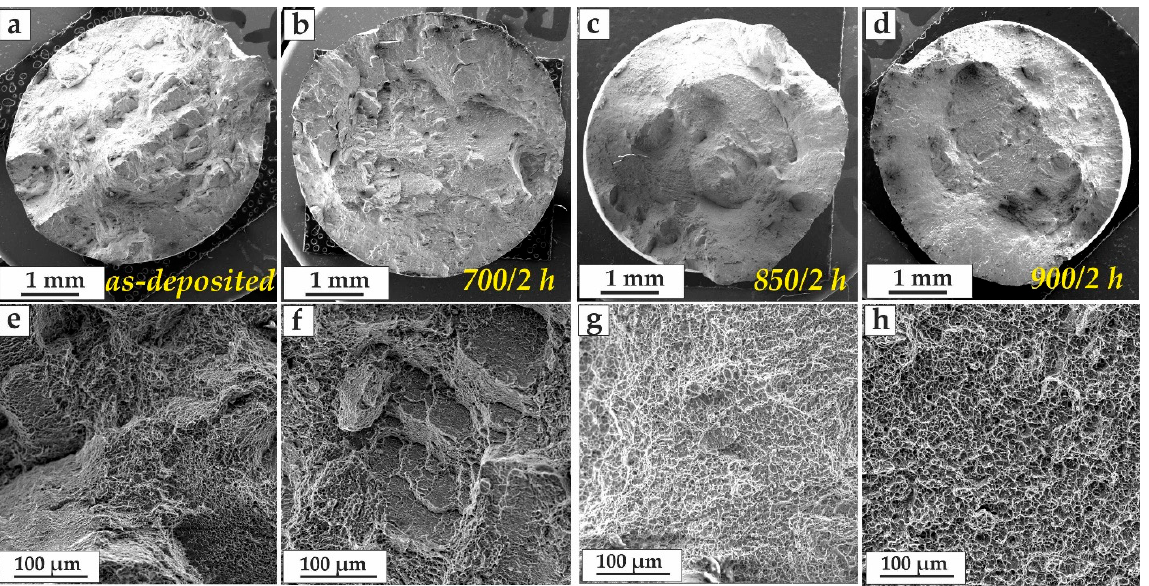
Figure 5. Fracture surface of as-deposited Ti-6Al-4V tensile samples performed in the horizontal direction ( x -axis) for ( a , e ) as-deposited; ( b , f ) HT = 700 °C; ( c , g ) HT = 850 °C; and ( d , h ) HT = 900 °C.